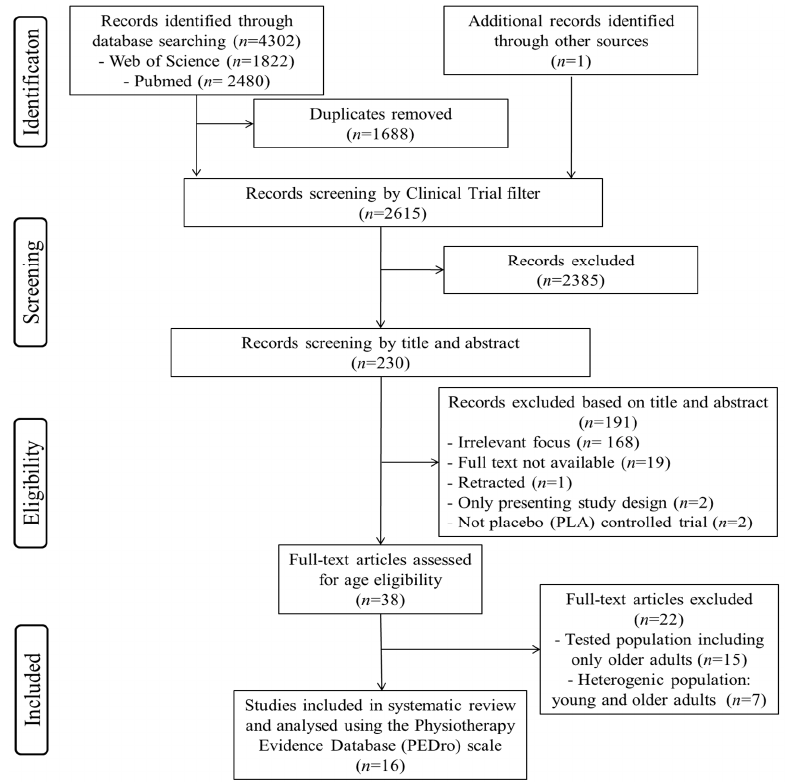
Figure 1. Flow diagram of the literature selection process.